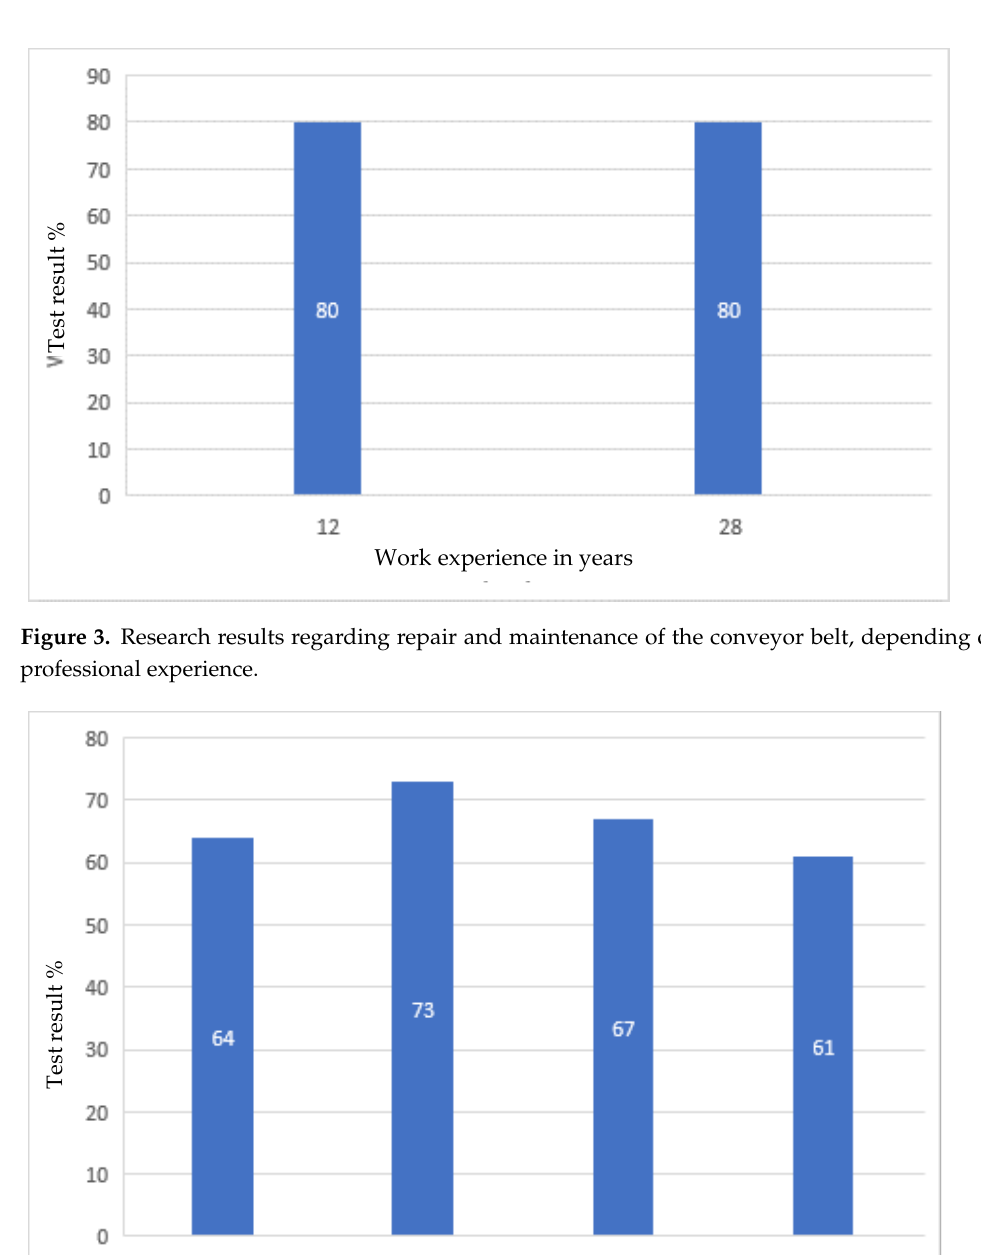
Figure 2. Research results regarding the emergencies of the conveyor belt, depending on profes- sional experience.